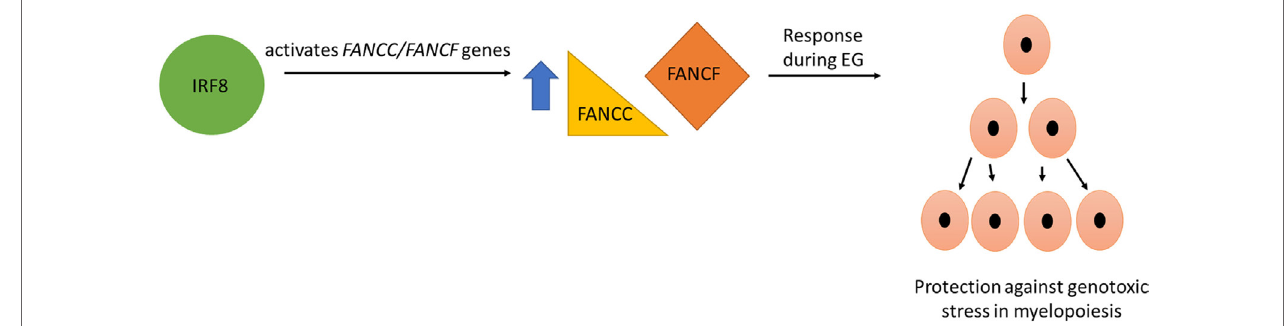
FiGURe 2 | IRF8 plays an important role in myeloid cell development during emergency granulopoiesis (EG) via regulating Fanconi DNA repair proteins. Some of the target genes of IRF8 include FANCC and FANCF, encoding Fanconi C and Fanconi F, respectively. These Fanconi proteins contribute to Fanconi DNA repair pathway activation during EG and protect cells from the genotoxic stress of myelopoiesis during rapid proliferation phase.